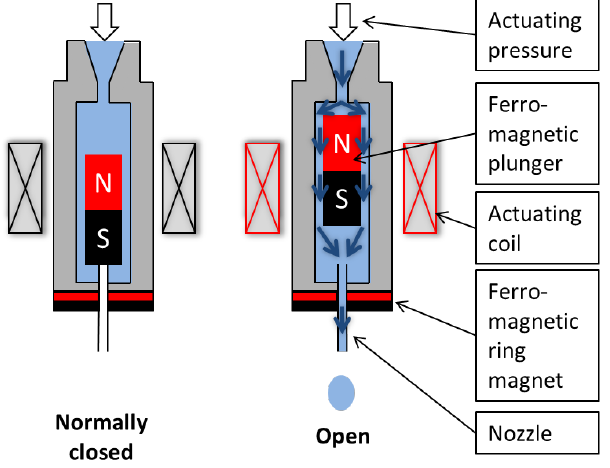
Figure 1. Working principle of the dispensing valve. Left: In its normally closed state, the ring magnet attracts the plunger and the valve seat is closed. Right: The actuating coil overcomes the attractive force between the ring magnet and the plunger to open the valve.